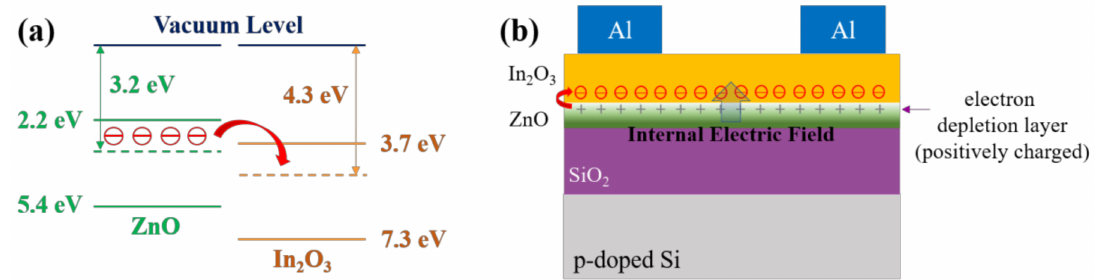
Figure 7. ( a ) Energy band structures of ZnO and In 2 O 3 and ( b ) Description of internal electric field induced at the ZnO/In 2 O 3 interface.